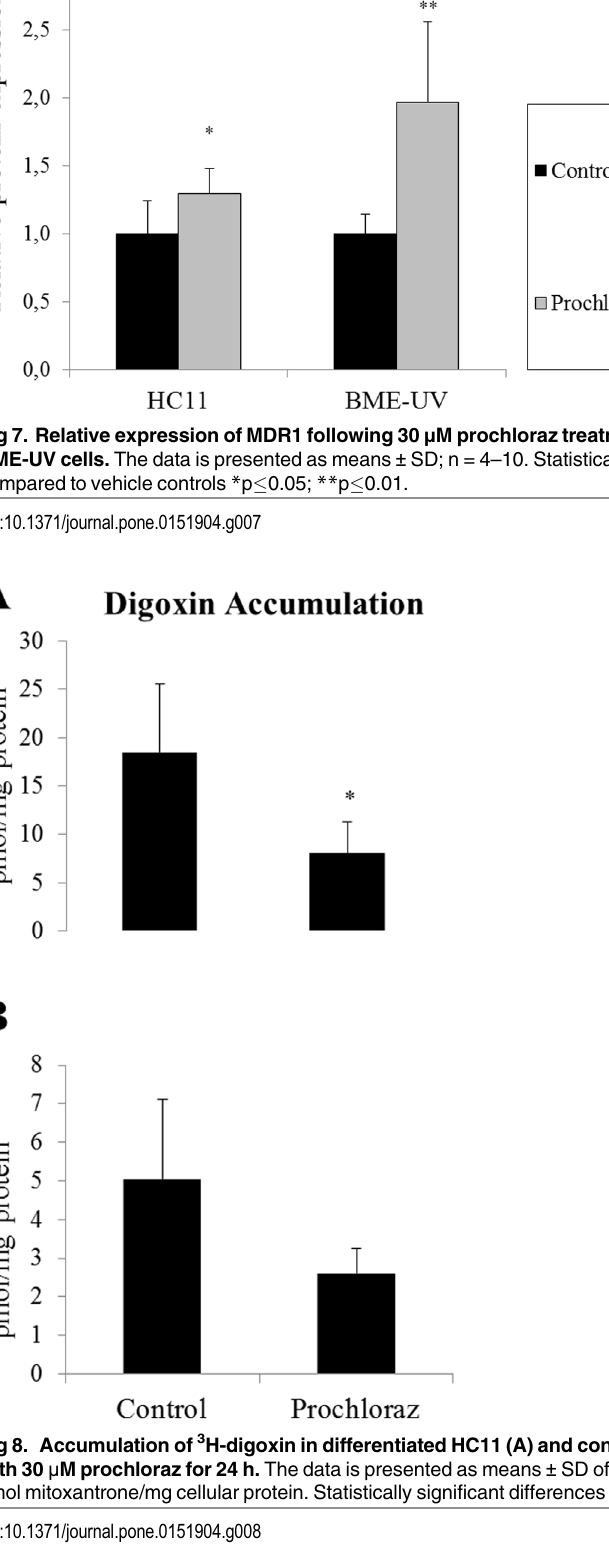
PLOS ONE | DOI:10.1371/journal.pone.0151904 March 30,